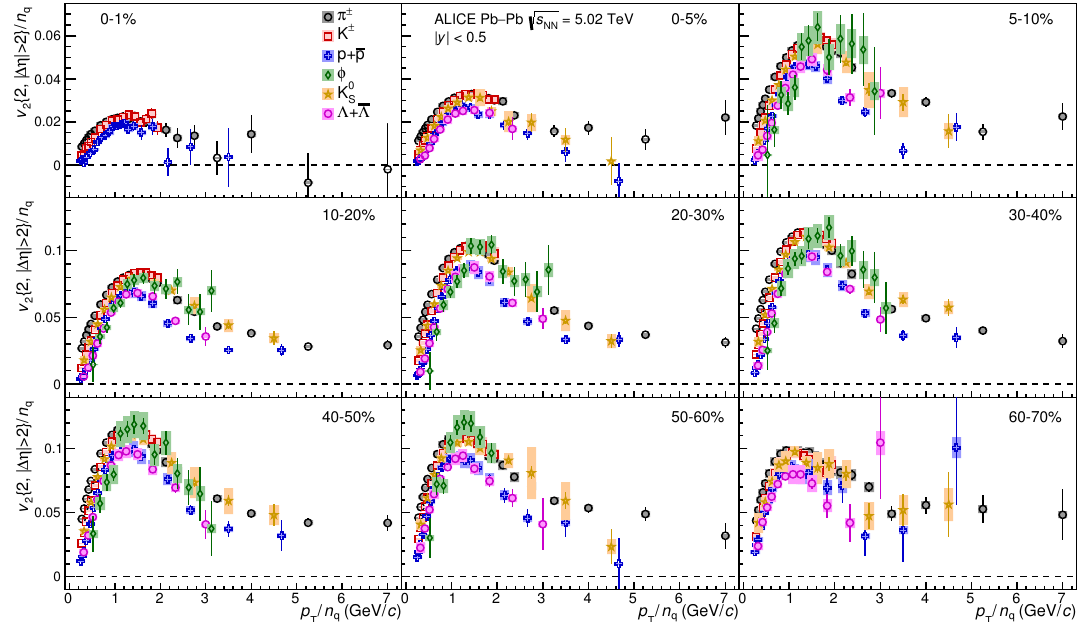
Figure 9 . (Colour online) The p T =n q dependence of v 2 =n q of (cid:25) (cid:6) , K (cid:6) , p+p, (cid:3)+(cid:3), K 0 (cid:30) -meson for various centrality classes. Statistical and systematic uncertainties are shown as bars and boxes, respectively.